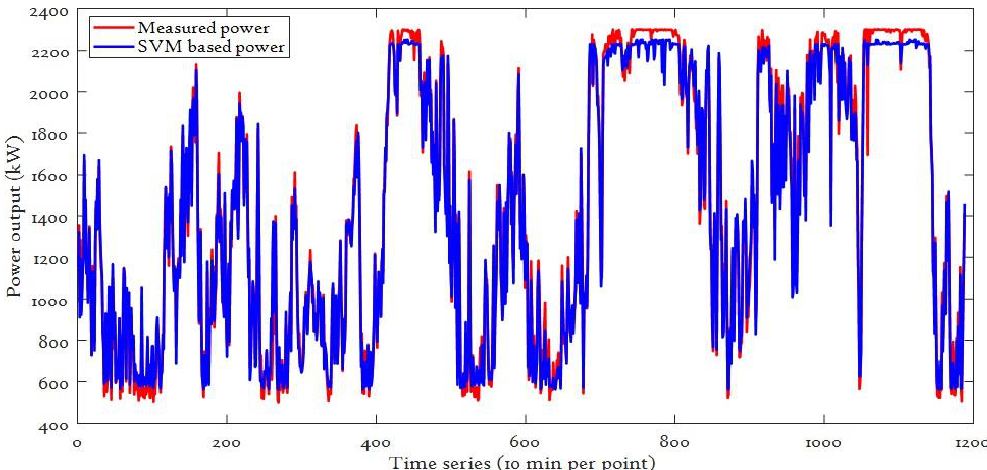
Figure 5. Comparative studies of SVM power curve model in terms of time-series.